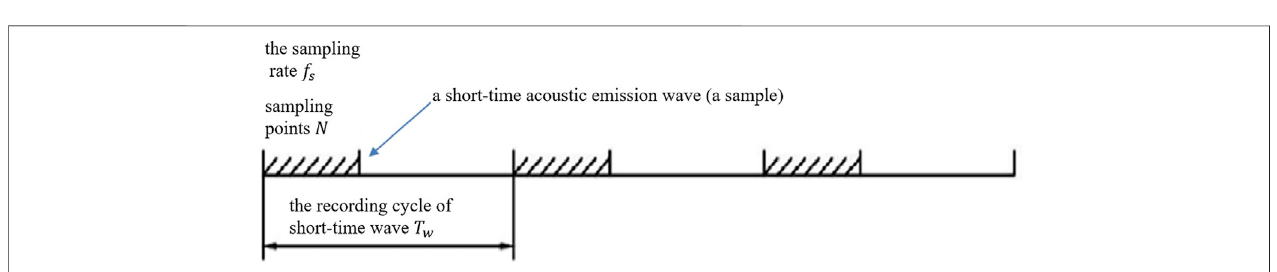
FIGURE 1 | Connection diagram of the experimental